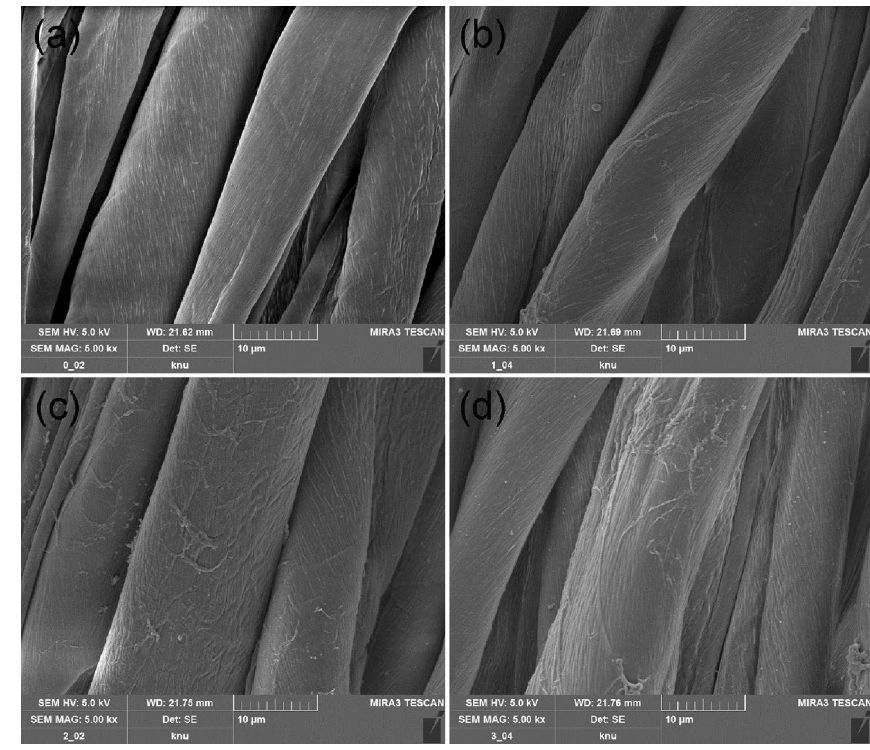
Fig. 5 SEM images ( 5000) of cotton fabrics: a untreated, b dyed with Aronia berries extract, c dyed × with the Aronia berries extract–chitosan mixture, and d dyed with Aronia berries extract after chitosan pretreatment